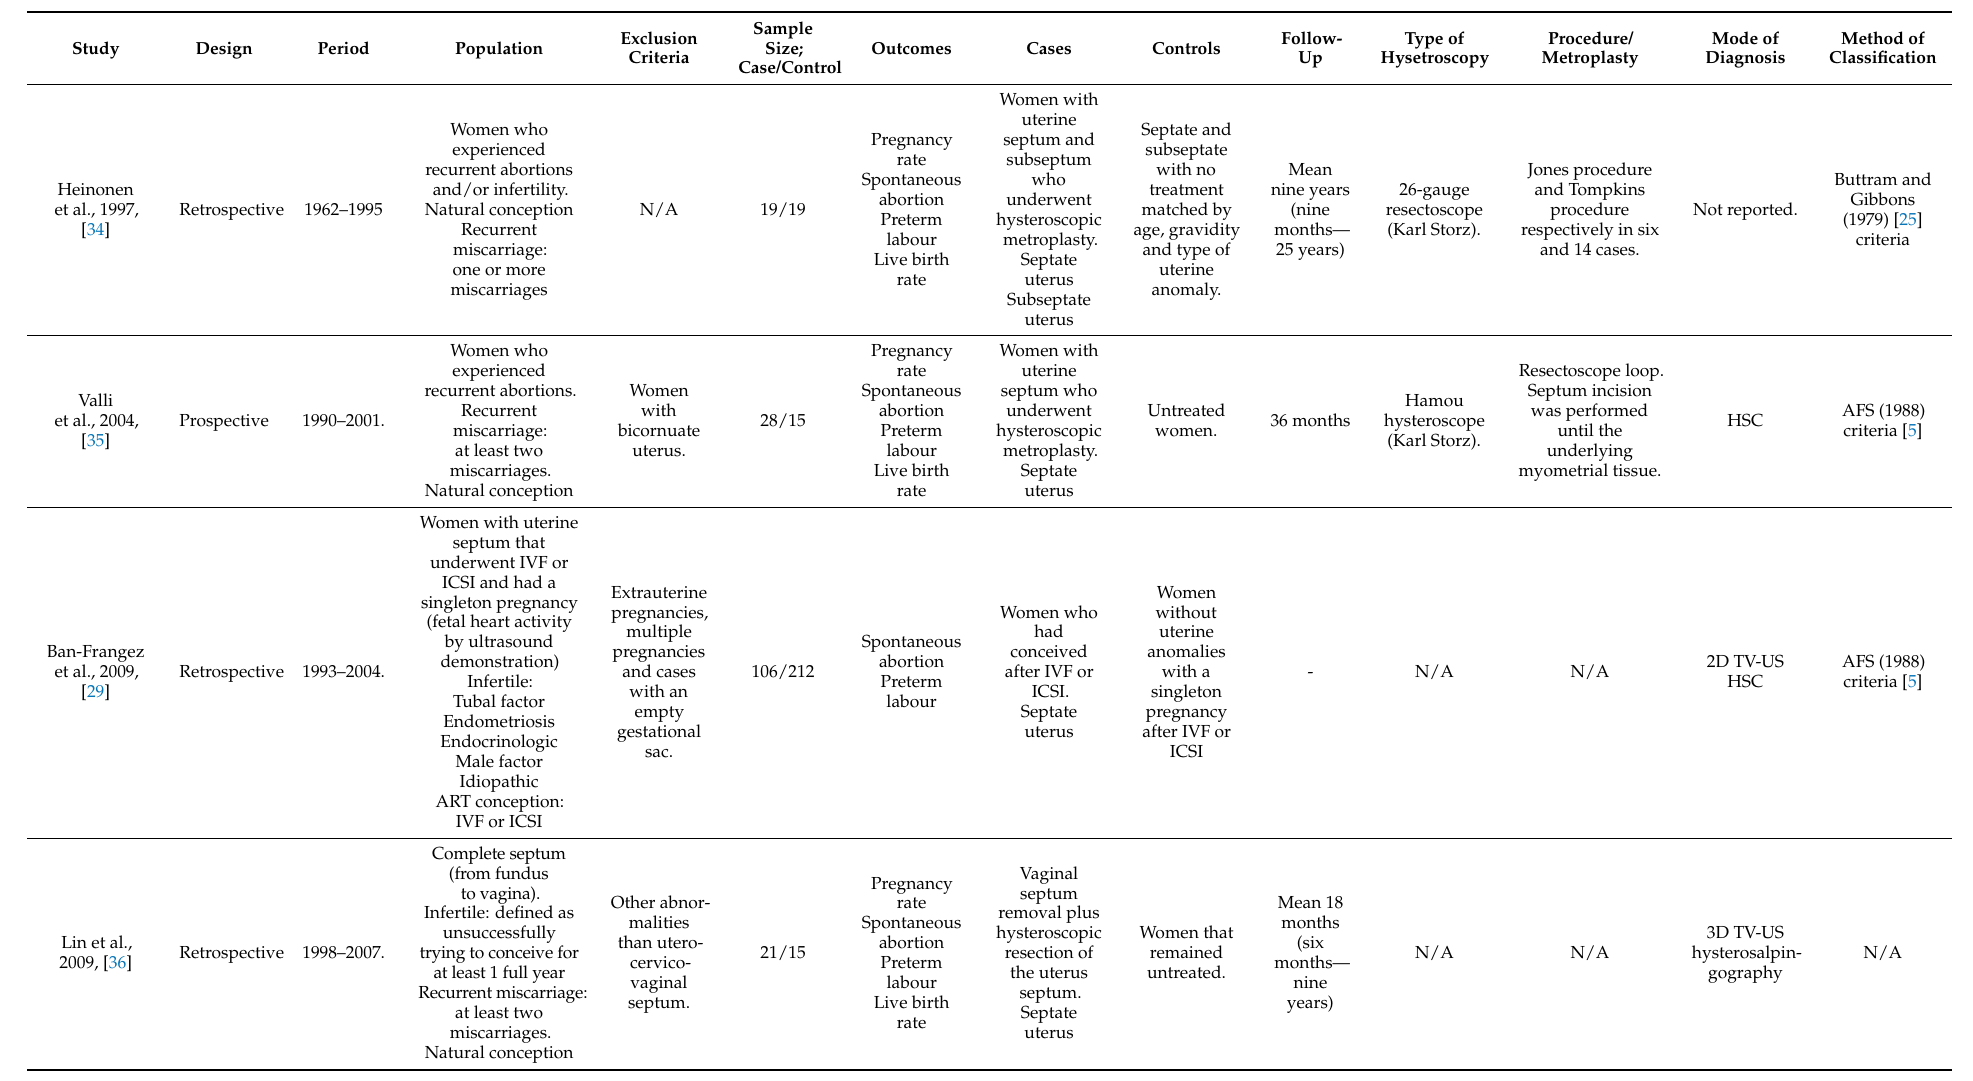
Table 2. General features of studies included in the meta-analysis: 2. Treated uterine septum versus controls (untreated